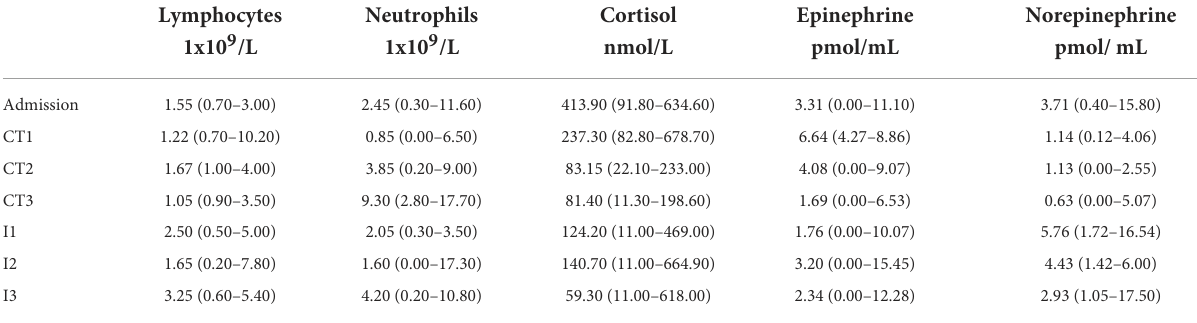
TABLE 1 Values of neutrophils, lymphocytes, cortisol, and catecholamines in puppies with sepsis secondary to canine parvoviral enteritis at admission and along 72hrs of treatment.